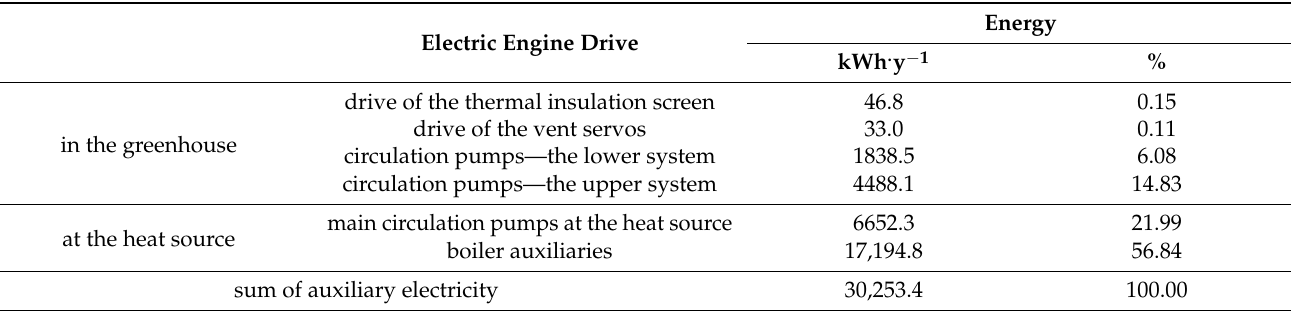
Table 4. Structure of electricity consumption for driving motors in technical systems of the greenhouse (scenario